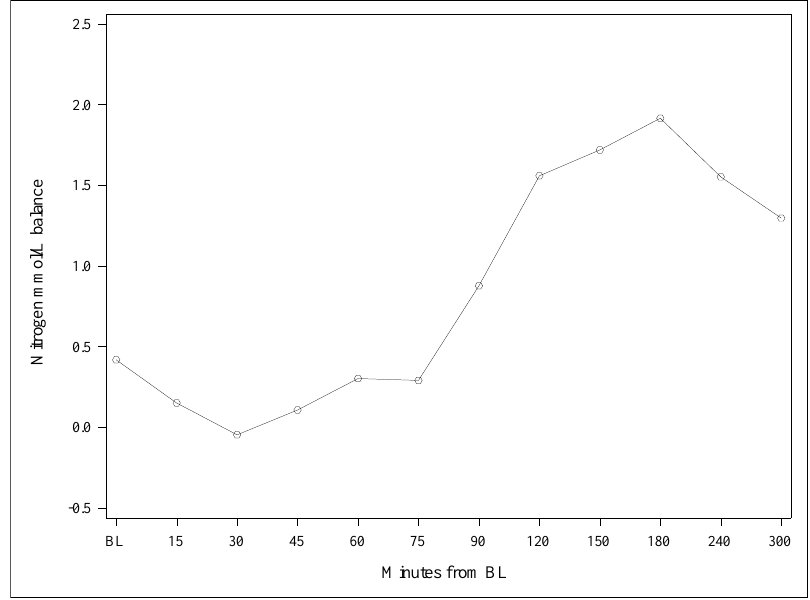
Figure 4. Differences between Deltas of nitrogen concentrations from amino acids, and nitrogen from blood urea nitrogen. BL, baseline.